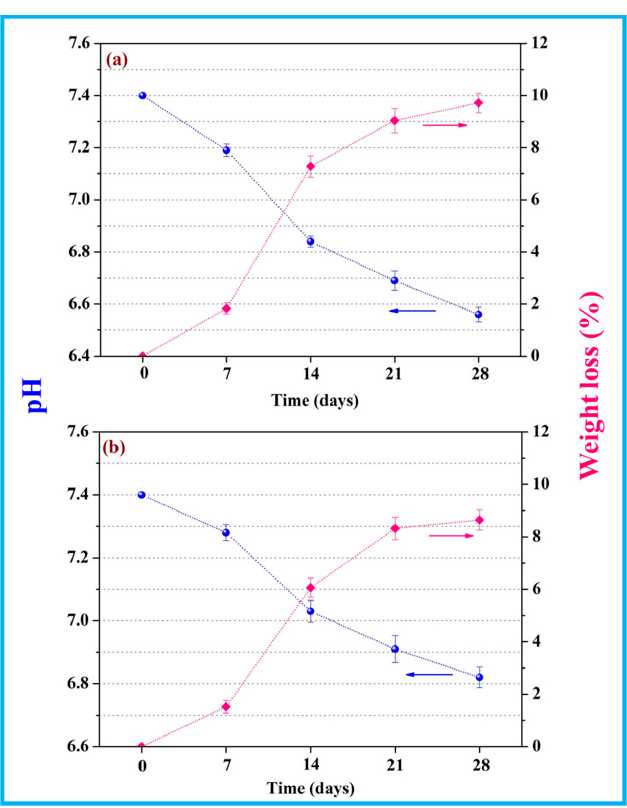
Figure 9. pH value and weight loss of ( a ) PEEK/PGA scaffolds and ( b ) PEEK/PGA ‐ 5%nTiO 2 . Polymers 2018 , 10 , x FOR PEER REVIEW